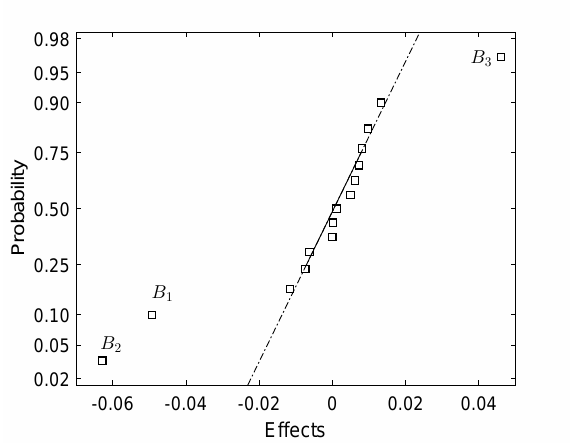
Figure 11. Normal probability plots for stage II showing effects on pressure ratio.